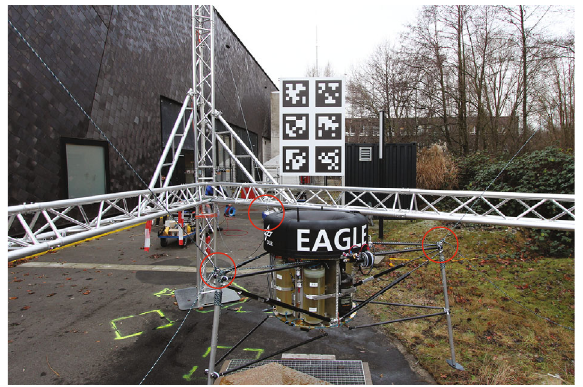
Figure 5: DLR ’ s experimental facility NEST (NEST Environment for Suspended fl ight Tests) for the vehicle EAGLE as an application for the modeling approach. The vehicle EAGLE is connected to the three ropes (visible in the red circles), which are attached to the top of the support structure. Three more ropes are used to limit the altitude. They are attached to the lower part of the support